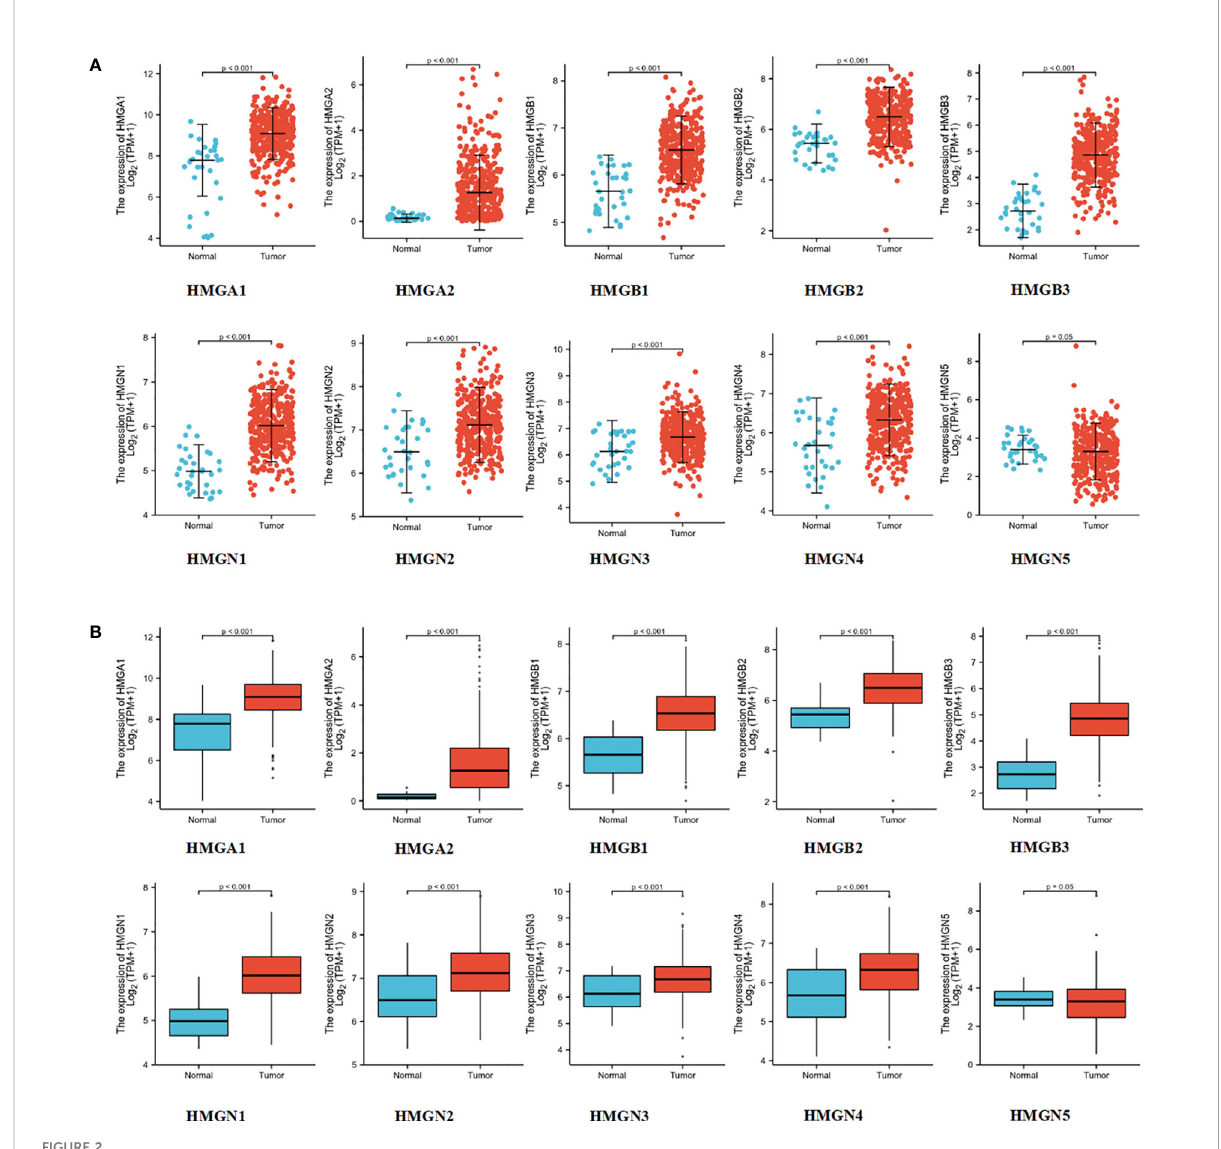
FIGURE 2 mRNA expression levels of HMGs in GC: (A) Scatter diagram; (B) Box